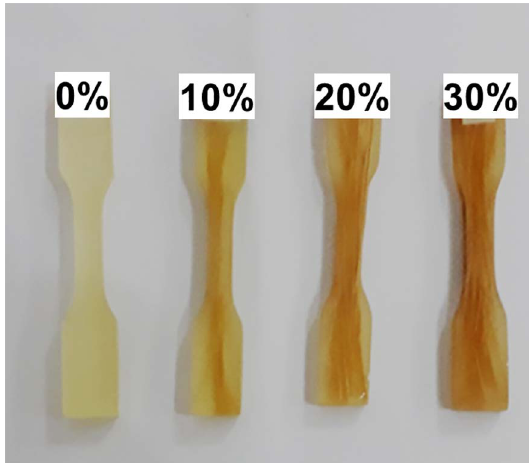
Figure 3. Typical plain epoxy and guaruman fiber reinforced composite tensile